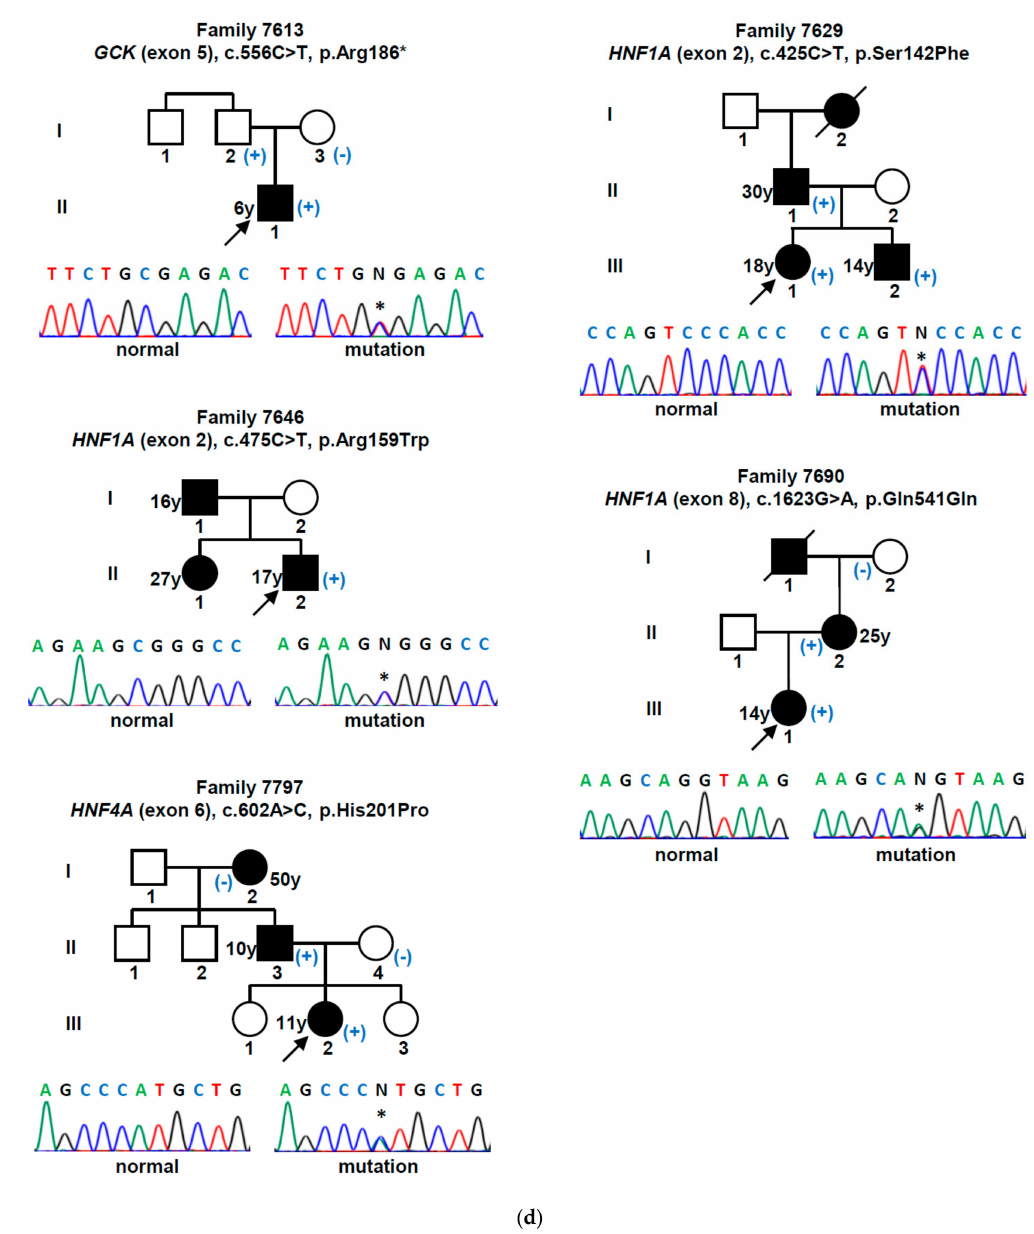
Figure 1. ( a – d ) Families with identified maturity-onset diabetes of the young (MODY) mutations. Filled symbols represent patients with diabetes, open symbols represent una ff ected individuals. Squares, circles, and diamond symbols denote males, females, and unspecified, respectively. Numbers within symbols indicate additional siblings with the same phenotype. Oblique lines through symbols represent deceased individuals. Arrows indicate the index cases. The age of diagnosis of diabetes (y, years), when known, is presented. The presence ( + ) or absence (–) of the mutation, when known, is presented. The chromatograms of the DNA sequence for normal individuals and for patients with mutations (asterisks) are presented below each